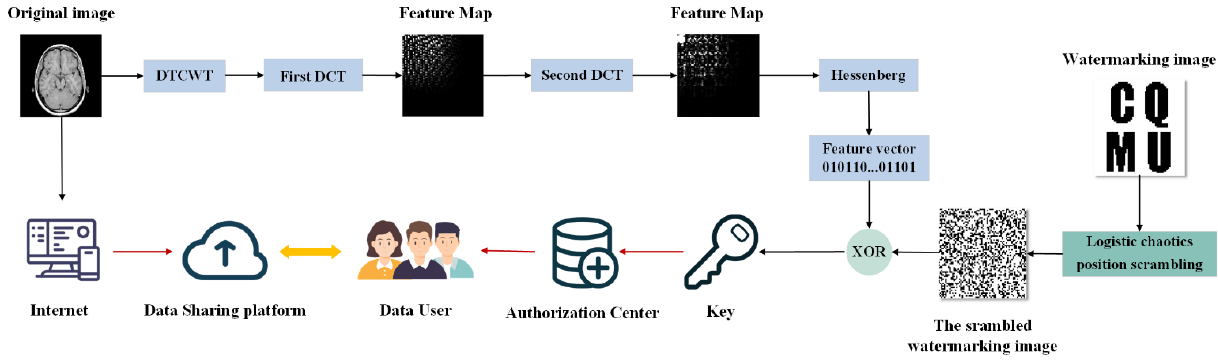
Figure 4. Watermarking-embedding